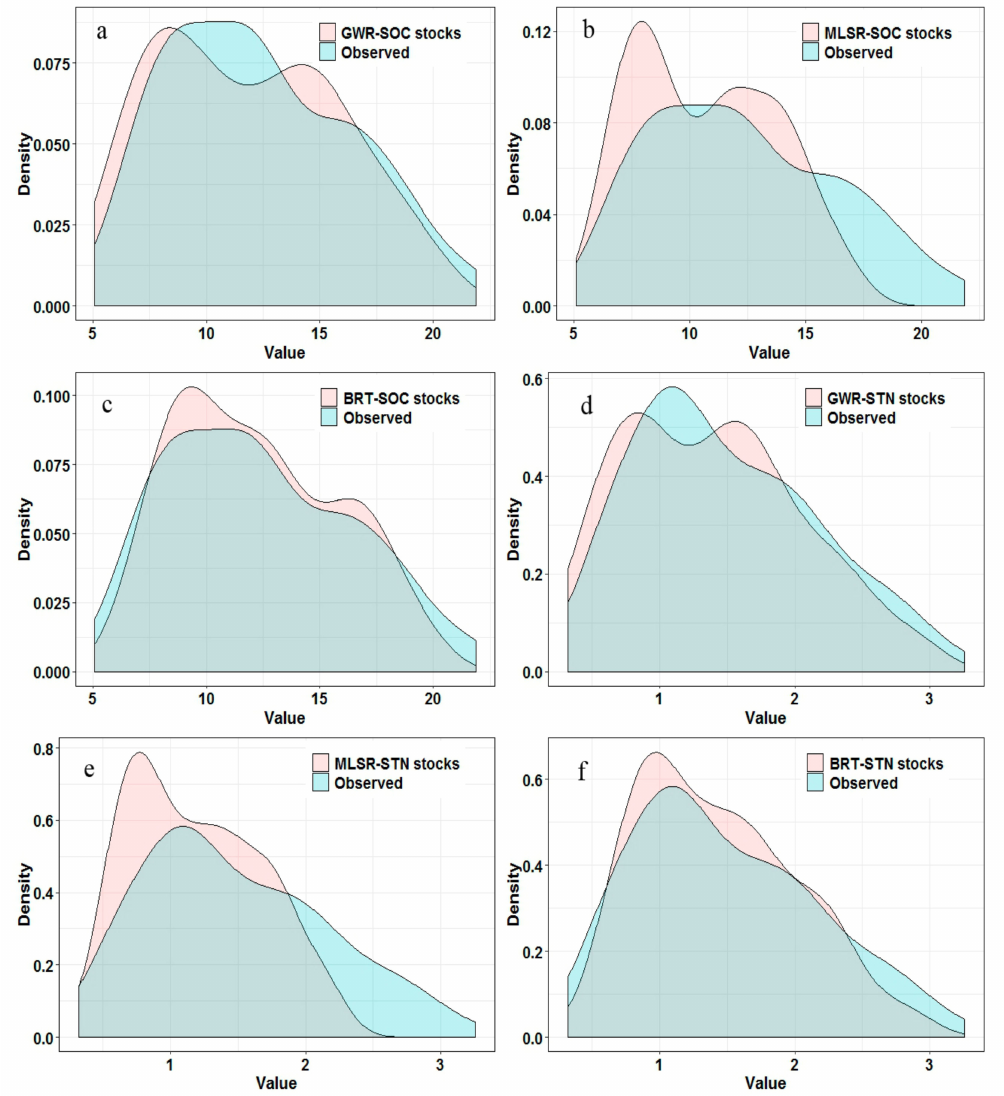
Figure 3. Density plots of the predicted and measured values of topsoil (0–30 cm) soil organic carbon stocks (SOC) (kg m − 2 ) and soil total nitrogen (STN) (kg m − 2 ). The predicted data are derived from geographically weighted regression (GWR) ( a , d ), multiple stepwise linear regression (MSLR) ( b , e ), and boosted regression trees (BRT) ( c , f